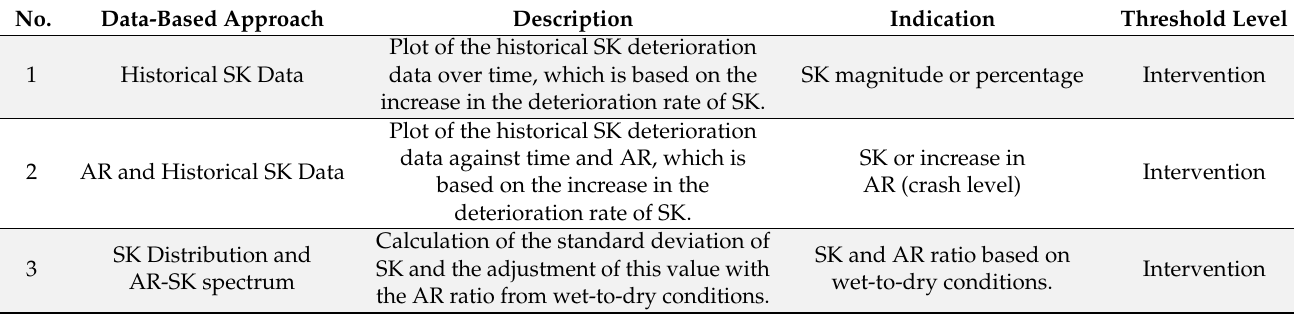
Table 6. Summary of commonly used approaches for skid resistance (modified from [77]).